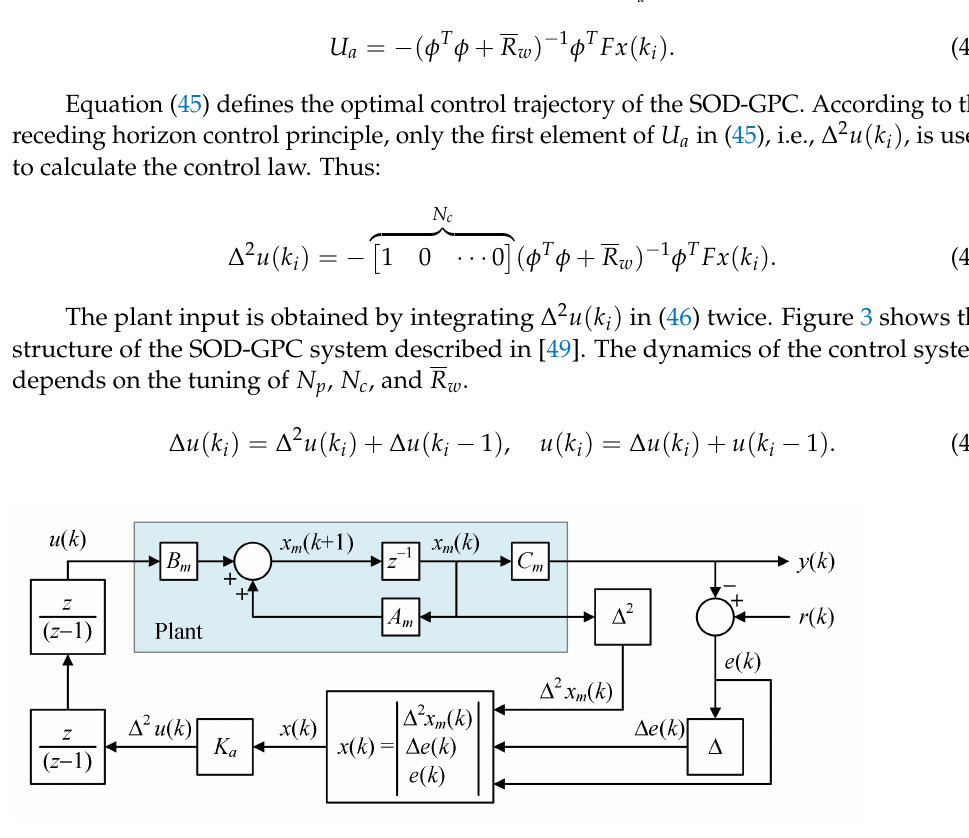
Figure 3. Schematic of the second-order difference GPC system